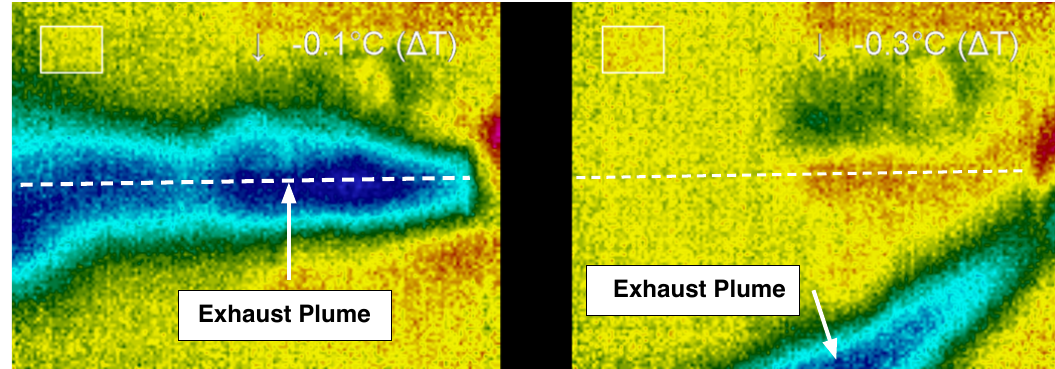
Figure 16. A flow instability at high flow rates through the thruster system. These instabilities are likely caused by incomplete mixing and reaction upstream of the